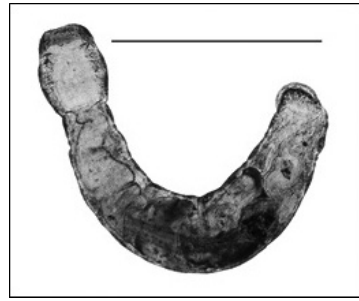
Figure 1. Branchiobdellida from crayfish host (Cambaridae) (scale 1 mm).